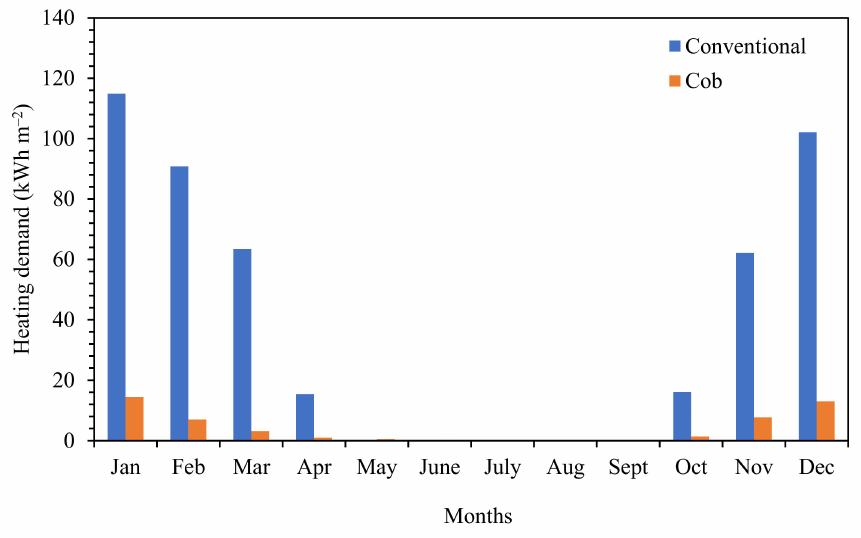
Figure 21. Heating demand for cob and conventional building over a year.